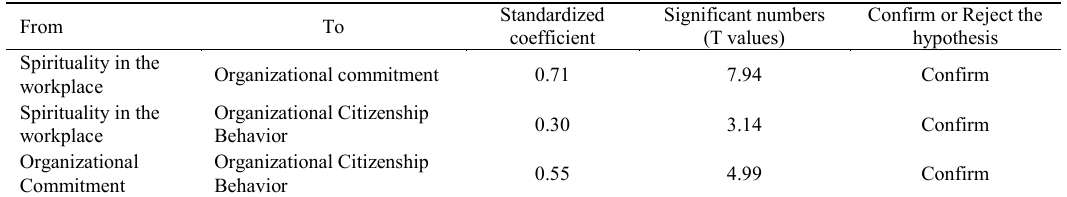
Table 3: Results of standard coefficients and significant numbers (confirmation or rejection of